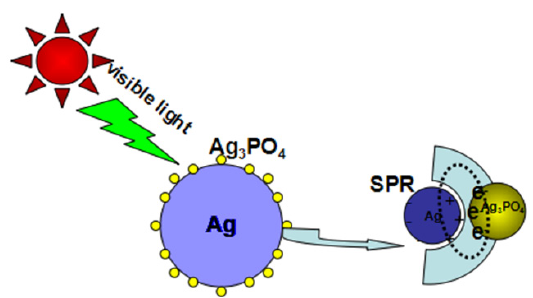
Figure 9. Schematic illustrations of the photocatalytic mechanism of the Ag PO /Ag 3 4